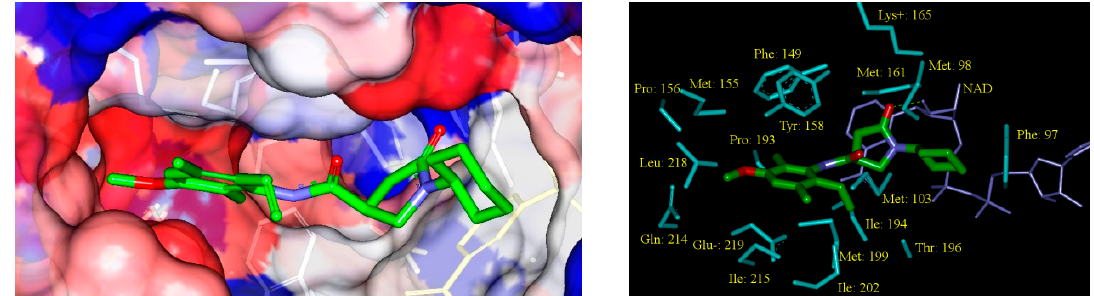
Figure 9. ( Left ) Connolly surface of the active-site of InhA of MTb with bound predicted most active PCM inhibitor 21-2-H-6-4. The binding site surface is colored according to residue hydrophobicity: red—hydrophobic, blue—hydrophilic, and white—intermediate; ( Right ) Close up of virtual hit 21-2-H-6-4 at the active-site of InhA. Interacting residues are colored blue and NADH is shown in purple color.